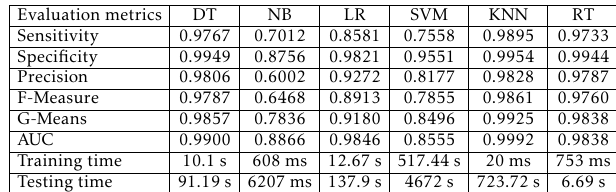
Figure 2. AUC - ROC Curve.